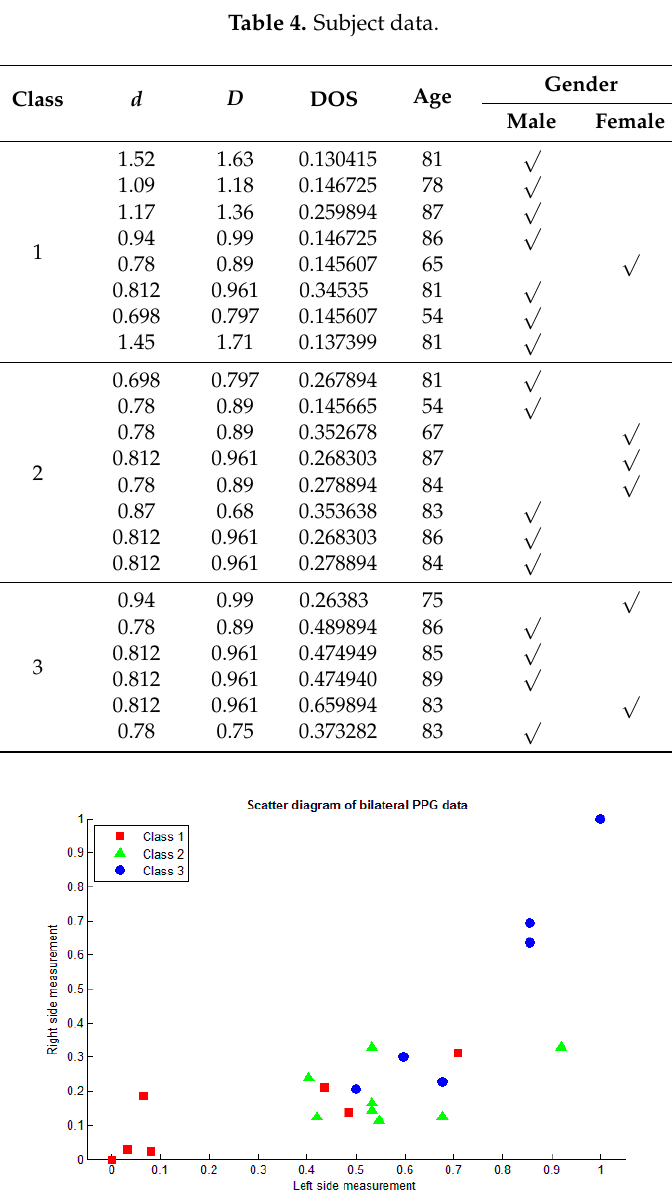
Figure 5. Monitoring and recording system: ( a ) PPG probes placement; and ( b ) the embedded system connected to a tablet PC.